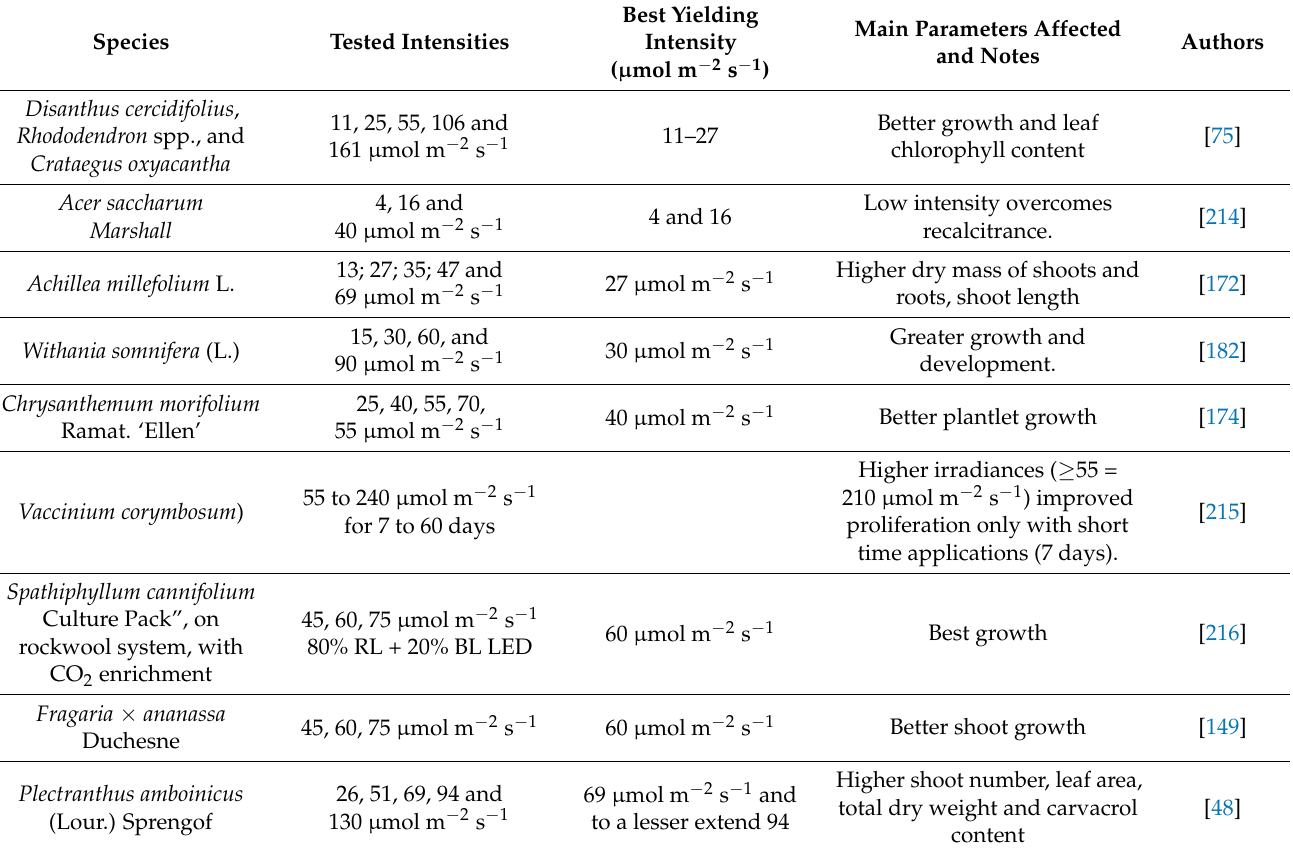
Table 3. Effects of different light intensities on shoot proliferation in increasing light-intensity